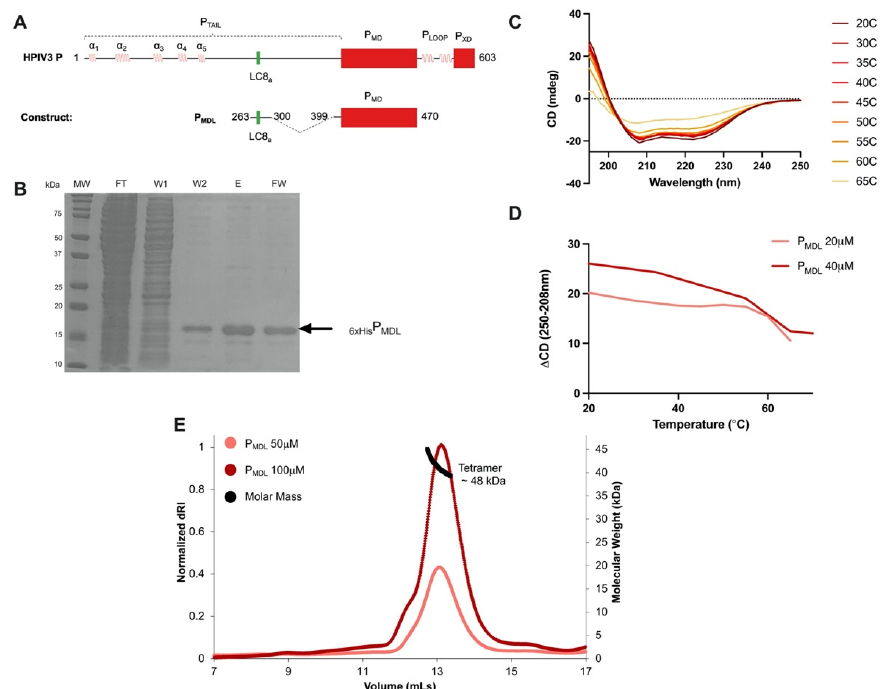
Figure 2. HPIV3 P forms a stable coiled-coil that is primarily a tetramer in solution. ( A ) Domain organization and construct design of P MDL based on the coiled-coil predicted region in HPIV3 P. ( B ) Purification of P MDL using TALON affinity nickel resin and a hexa-histidine N-terminal tag on P MDL . MW, molecular weight; FT, flow-through; W1, wash 1; W2, wash 2; E, elution in 350 mM imidazole; FW, final wash in 350 mM imidazole. ( C ) Circular dichroism spectra of 20 μ M P MDL at increasing temperature. ( D ) 40 μ M P MDL (two-fold concentrated) CD spectra were collected at increasing temperatures, and the 208–250 nm difference was plotted against increasing temperature points for both high and low concentrations. ( E ) Multi-angle light scattering of P MDL at both 50 and 100 μ M concentrations; dRI, refractive index.